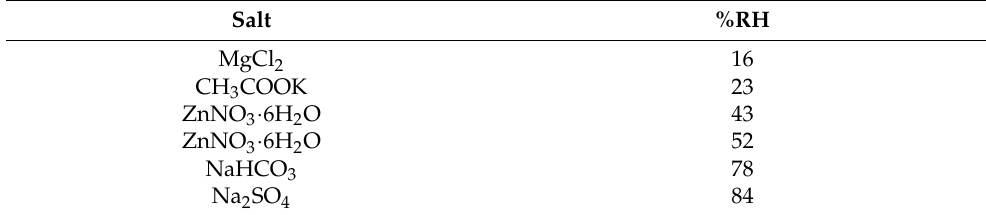
Table 1. List of salt used for controlling the %RH value in the gas box.